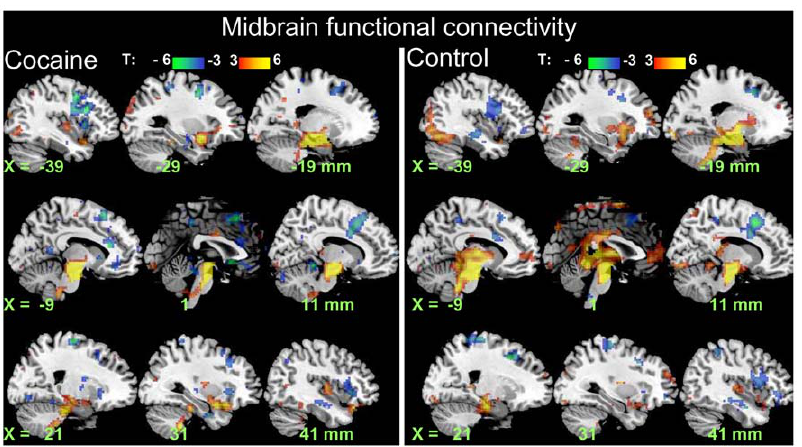
Figure 6. Functional connectivity of midbrain. Statistical maps of normalized CM coefficients during task epochs of the DW task across word conditions (‘‘Drug’’ and ‘‘Neutral’’) for 20 cocaine abusers (left) and 20 healthy matched control subjects (right). Random-effects analyses (two-way repeated measures ANOVA). Red-yellow and blue-green color bars show the t -score windows.